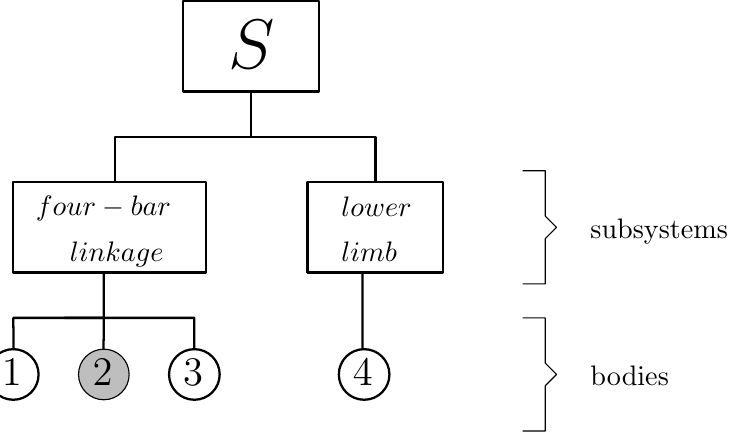
Figure 4. The system S: a four-bar linkage (bodies 1, 3) and the human lower limb (body